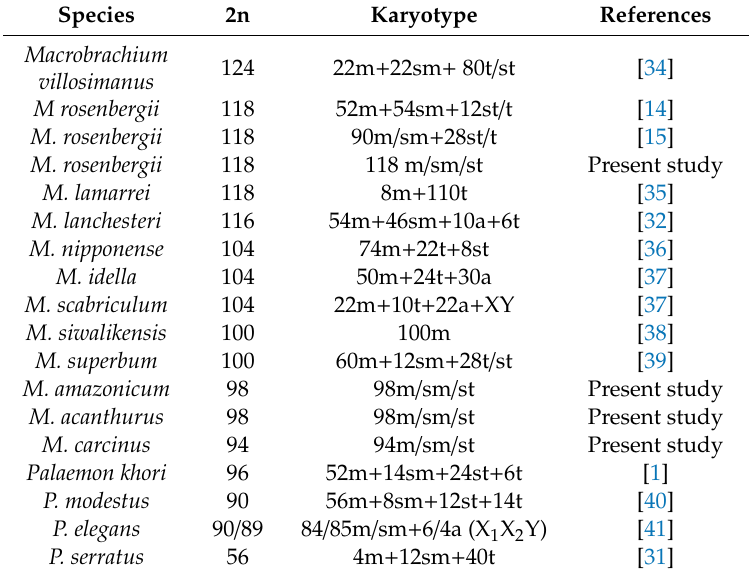
Table 1. Cytogenetic data for the family Palaemonidae